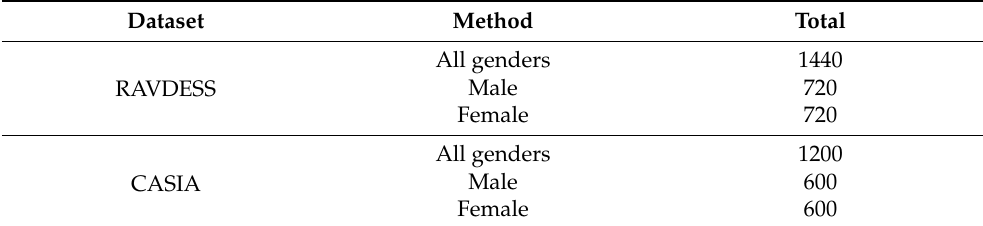
Table 2. Emotional speech dataset.